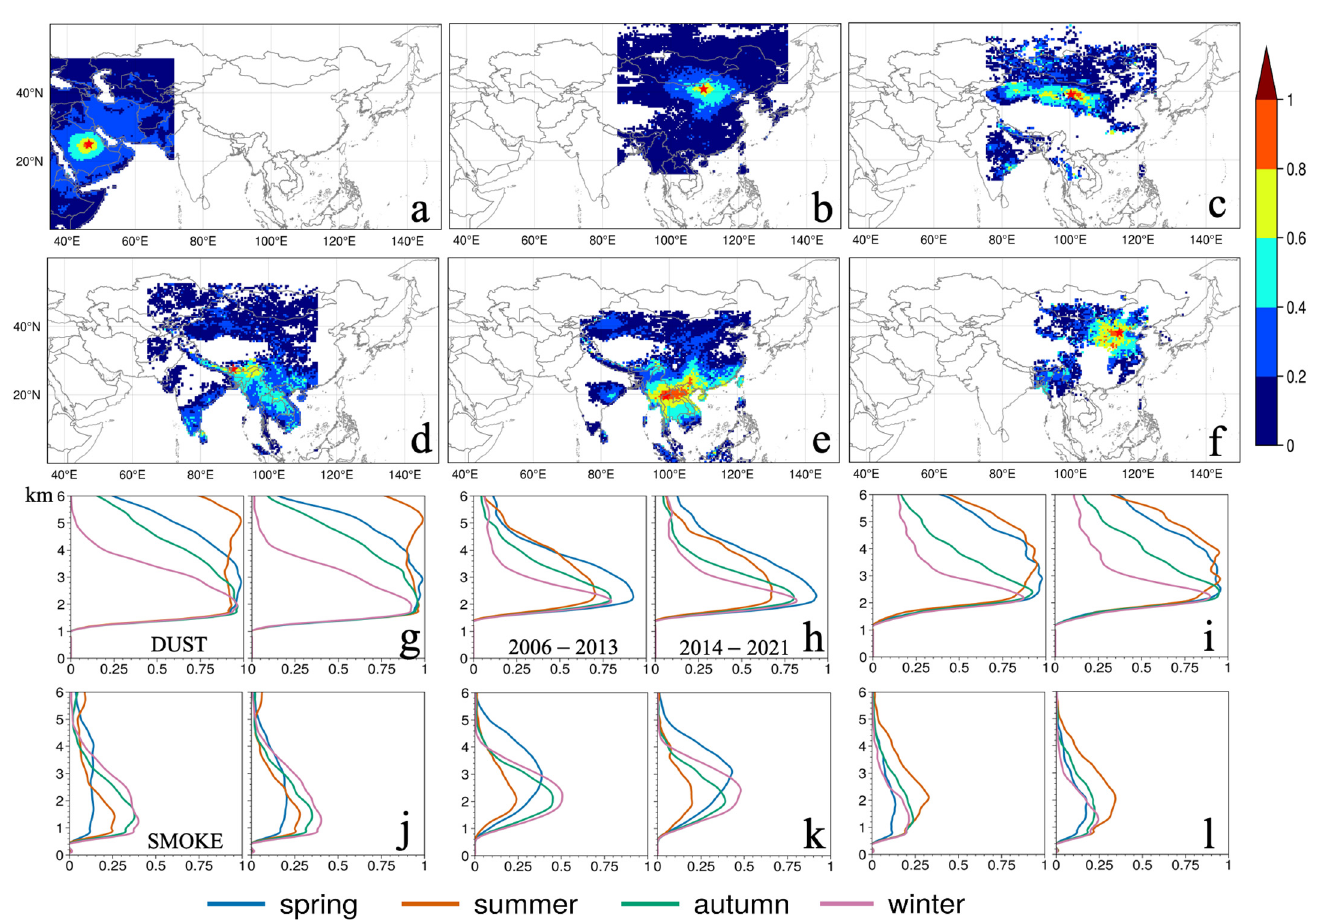
Figure 4. The correlation coefficient (R) between MODIS and AERONET daily AOD of each pixel near the sites: ( a ) Solar_Village site; ( b ) AOE_Baotou site; ( c ) Zhangye site; ( d ) Thimphu; ( e ) Son_La site; ( f ) Shijiazhuang-SZF; ( g – l ): seasonal vertical profiles of FoO with two aerosol types (dust and smoke) and different season (lines of different colors) during two periods over the area with R > 0.6 for the same sites as panels ( a – f ); x -axis represents the normalized frequency from 0 to 1, and y -axis represents the altitude from 0 to 6 km.